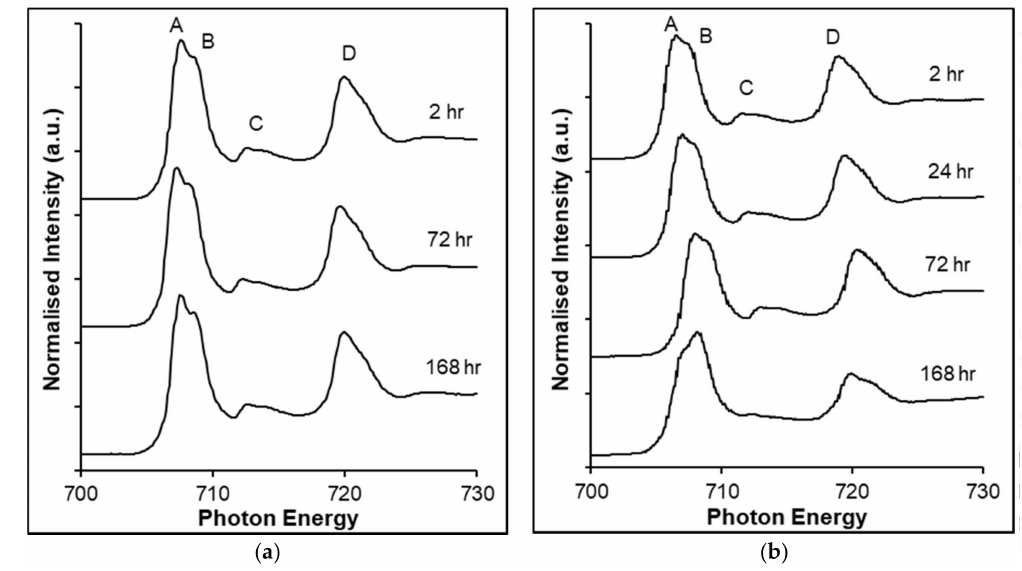
Figure 3. The surface iron speciation of pyrite after 2, 24, 72 and 168 h of exposure to: ( a ) HH medium; and ( b ) A. ferrooxidans